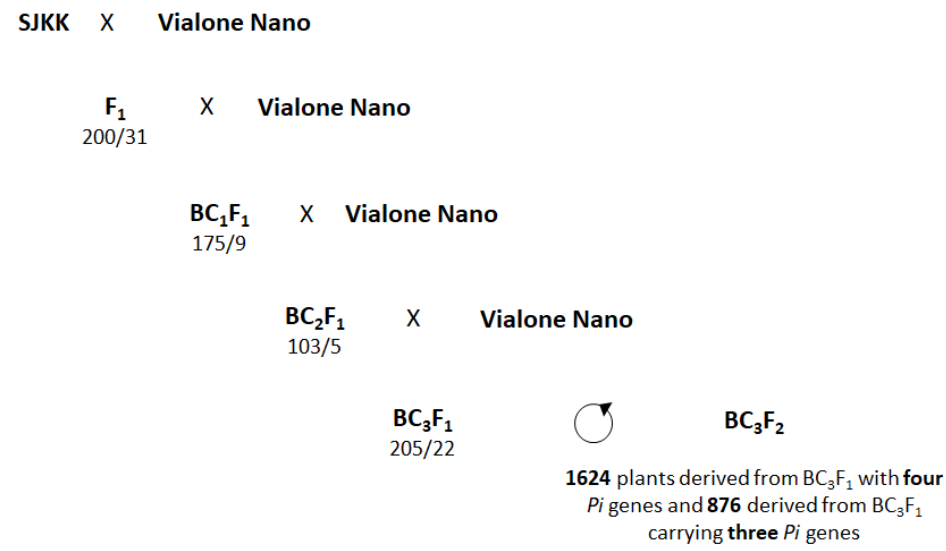
Figure 3. MABC scheme for the introgression of the four Pi genes ( Pib , Piz , Pik , and Pita ) where SJKK acted as donor parent (DP) and Vialone Nano as recurrent parent (RP). Numbers indicate the tested plants with respect to the number of plants having the desired marker alleles.